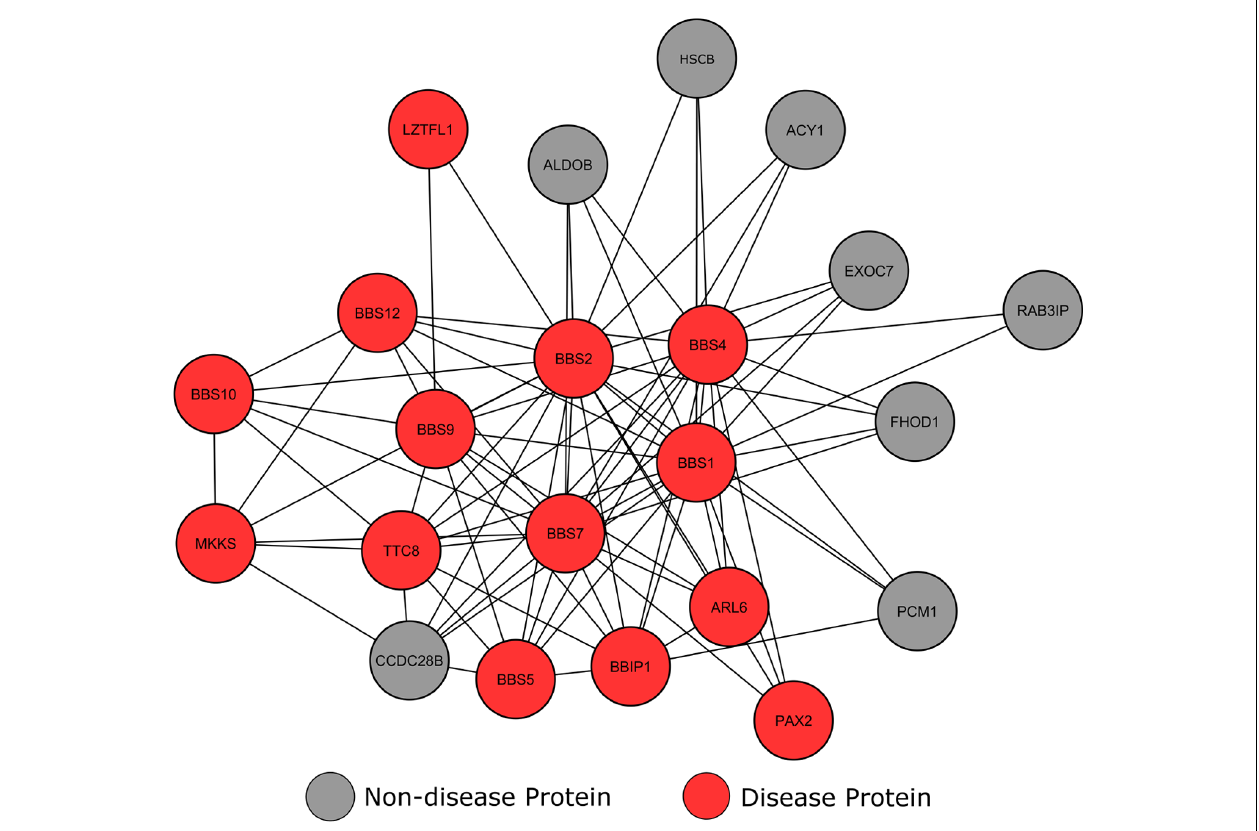
FIGURE 5 | Interconnectivity of Bardet–Biedl syndrome genes. Circular nodes represent proteins, with the lines between them signifying an interaction between the two